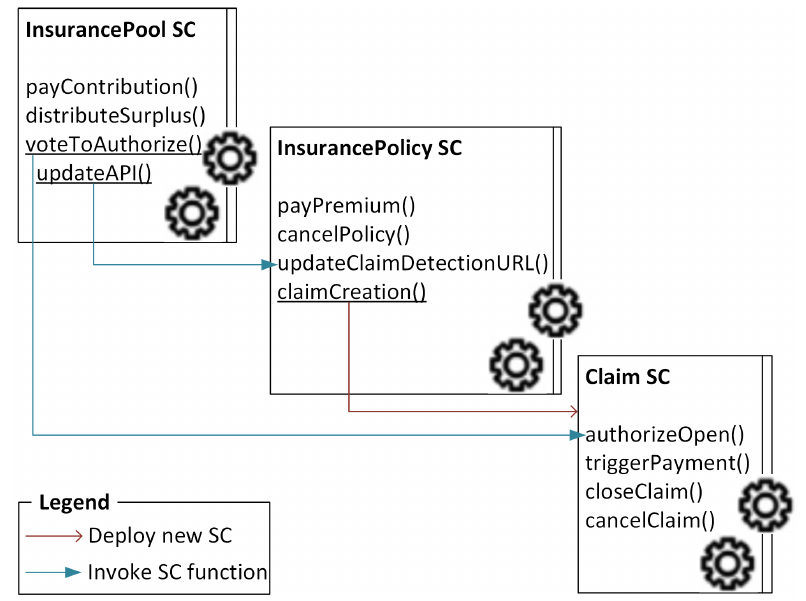
Figure 2. Smart contracts for insurance